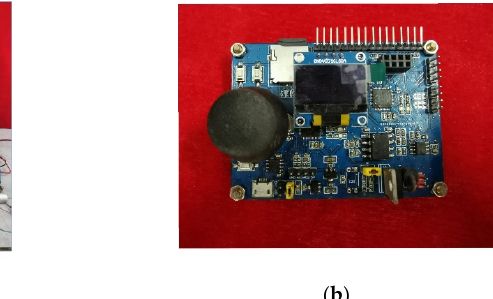
Figure 14. Prototype of the initial and optimal MR valve: ( a ) valve parts, ( b ) valve assembly. 1. Left end cover, 2. Valve body, 3. Left positioning plate, 4. Magnetic ring, 5. Right end cover, 6. Damping disk, 7. Nonmagnetic disk, 8. Right positioning plate, 9. Nonmagnetic ring.